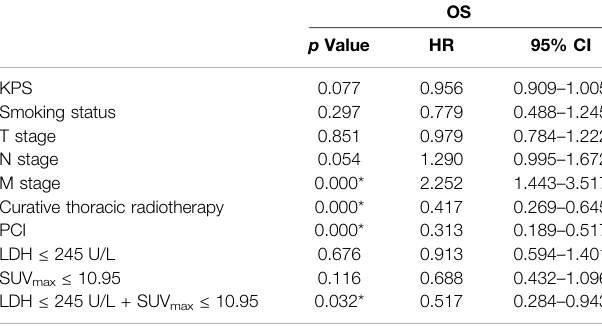
TABLE 3 | Multivariate analysis of overall survival in 118 patients with SCLC. OS